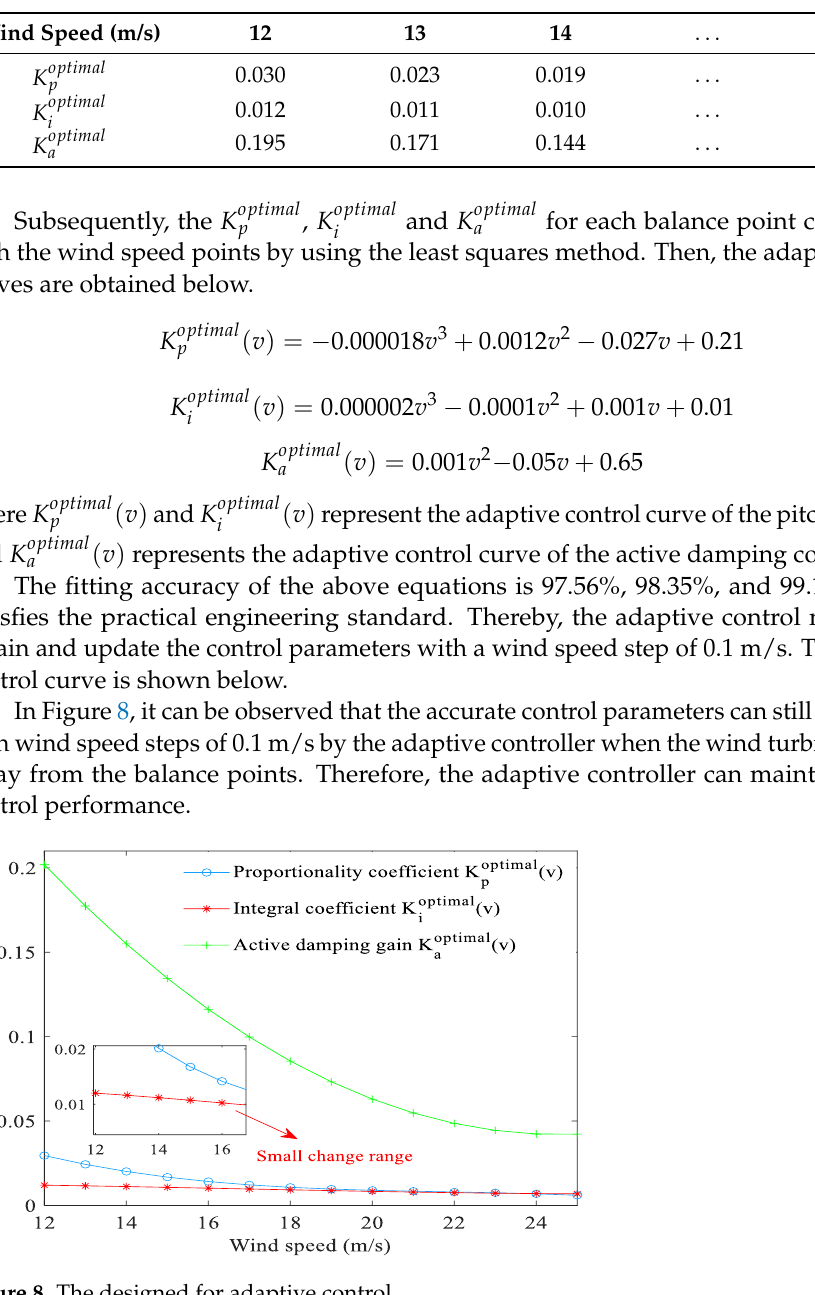
Table 1. The adaptive control parameters designed for each balance point.